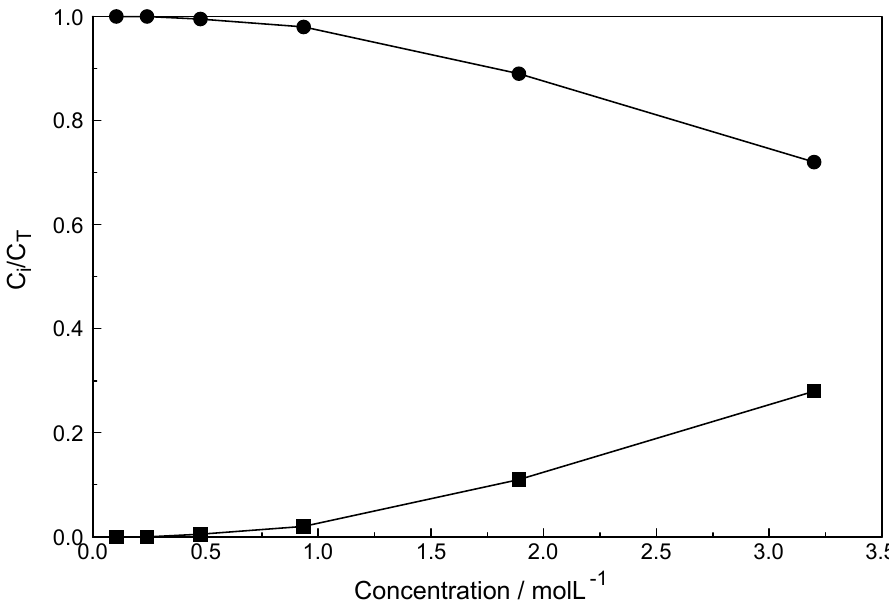
Figure 6. Fraction of species detected by quantitative Raman spectroscopy. The filled circles denote the [Lu(OH 2 ) 8 ] 3+ , the fully hydrated Lu 3+ and the filled squares the 1:1 chloro-complex species. The logK 1 ′ value measured by Raman spectroscopy is − 0.62 (I = 5.61 mol·L − 1 ) and reveals the weak nature of the chloro-complex in LuCl 3 (aq) at 23 °C. Literature values for logK 1 for rare earth